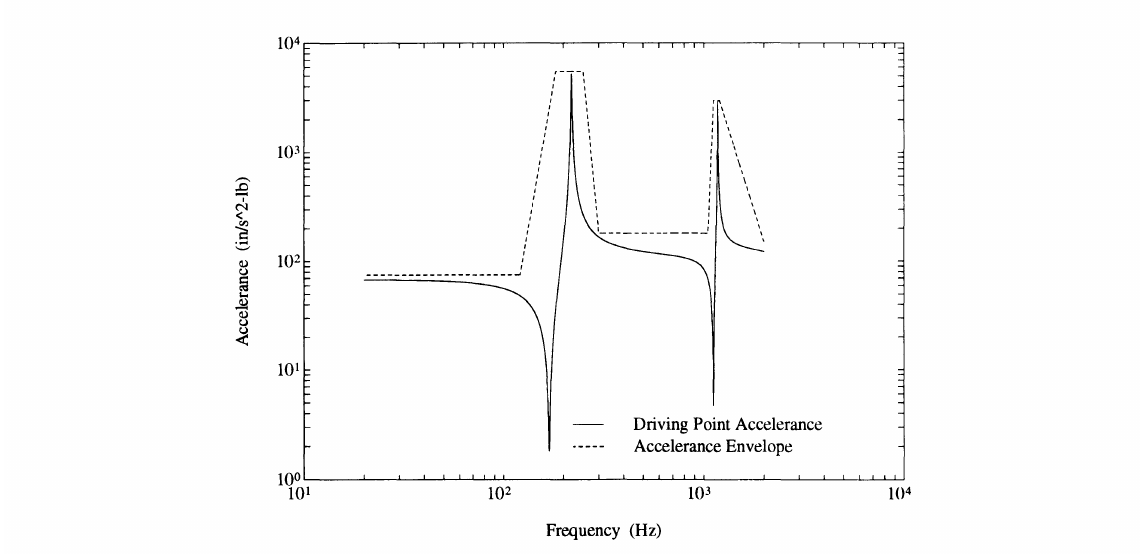
FIGURE 7 Driving point accelerance FRF of subsystem structure with envelope of peak